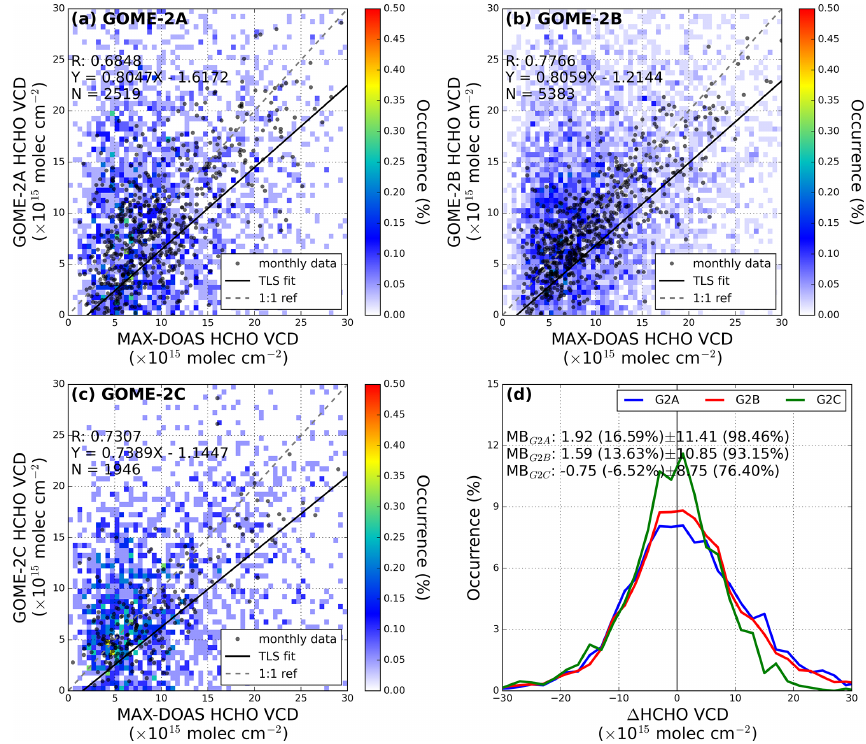
Figure 24. Comparison of daily and monthly total column HCHO measured by the ground-based MAX-DOAS to (a) GOME-2A, (b) GOME-2B, and (c) GOME-2C. Histograms of the difference in total column HCHO between GOME-2 and MAX-DOAS are shown in panel (d) . Co-located daily and monthly averaged data are used in the comparison. Total least-squares regression is based on monthly data.